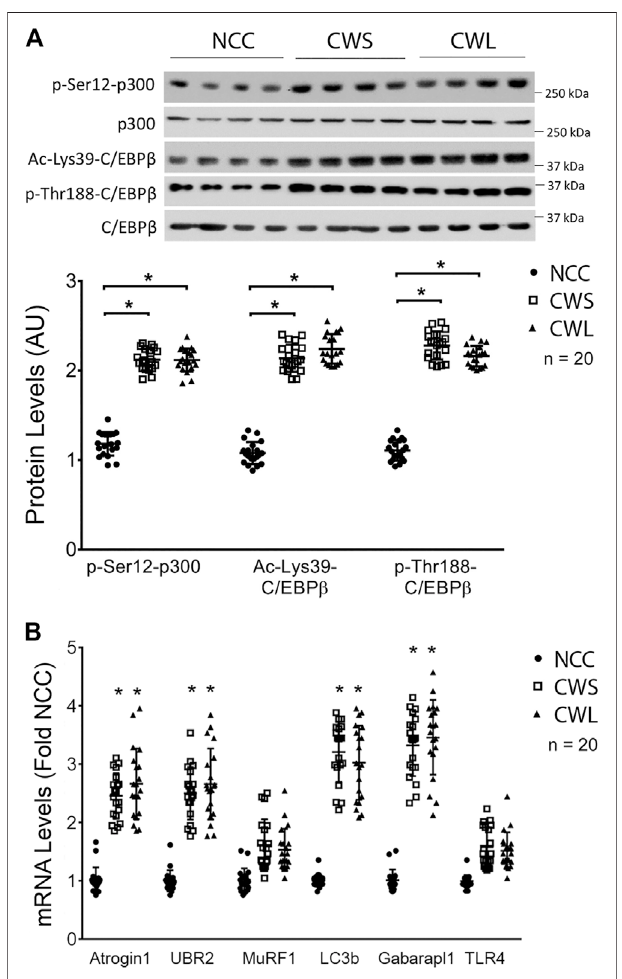
FIGURE 2 | Higher activity of p38 β MAPK effectors p300 and C/EBP β are accompanied by increase in expression of C/EBP β -responsive genes in UPP and ALP in RA of cancer patients. (A) Active p38 β MAPK effectors p300 and C/EBP β were analyzed by Western blotting. (B) The mRNA levels of C/EBP β -responsive genes in the UPP and ALP were analyzed by qPCR. The mRNA of TLR4 was also monitored. Data were analyzed by one-way ANOVA combined with Tukey ’ s test. * denotes p < 0.05 compared to